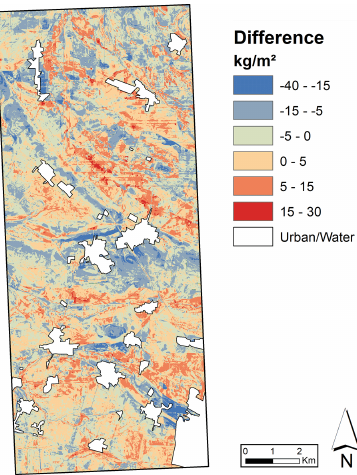
Figure 5. Calculated difference between the direct and indirect approaches of modelling the total SOC stock . Negative values are where the indirect approach predicted more SOC stock than the di- rect approach and positive values are where the indirect approach predicted less.